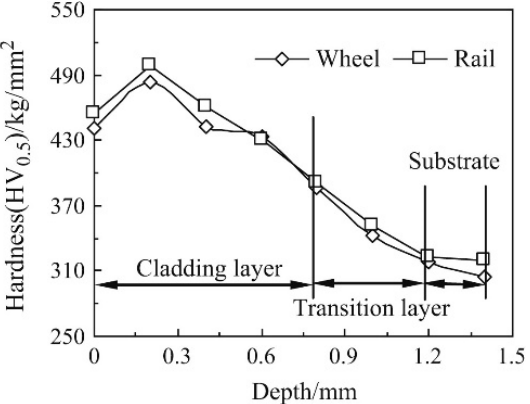
Figure 2. The change of hardness along with the depth direction of the wheel/rail rollers cladded by Co-based alloy powders (reprinted from Ref. [31], copyright (2014), with permission from Elsevier).